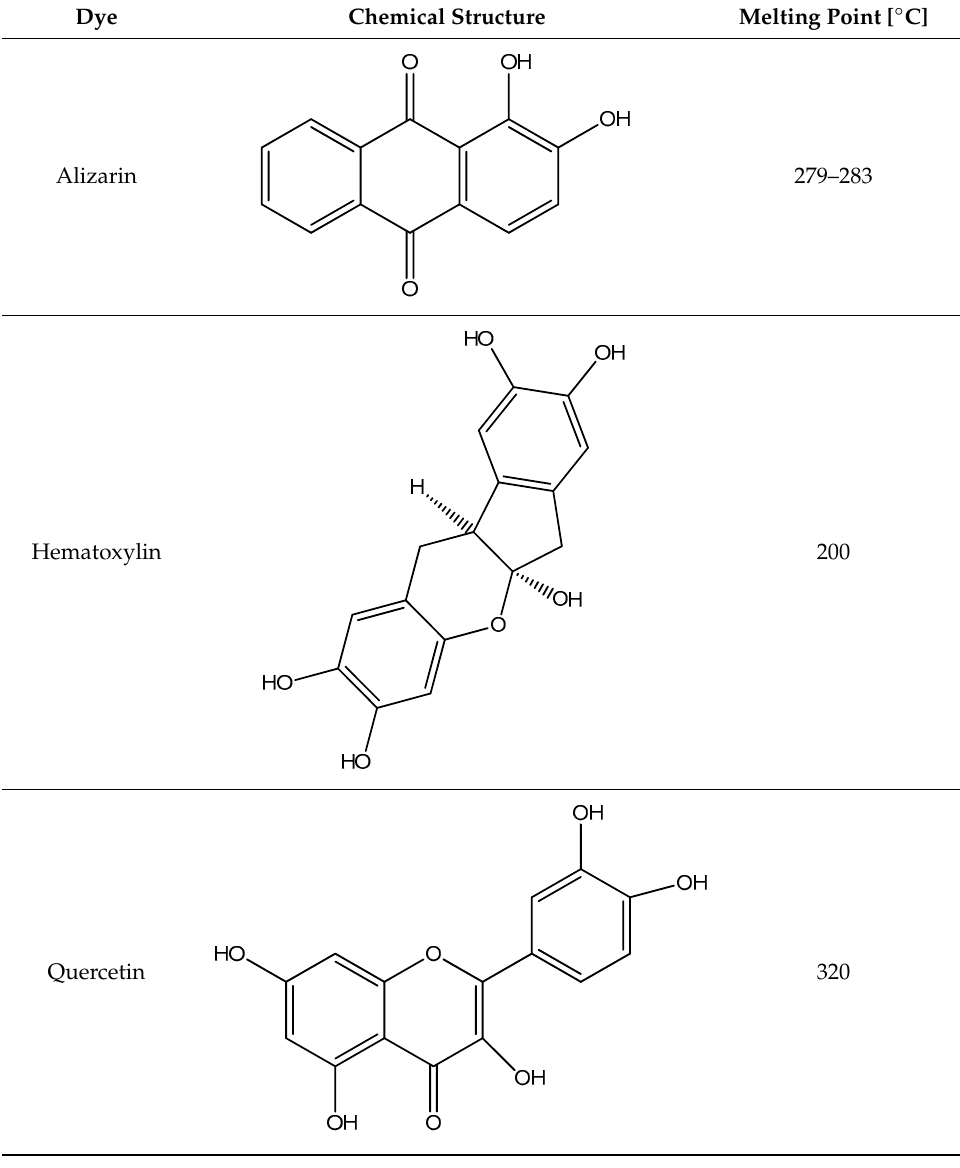
Table 2. Compound abbreviations according to the dye and weight